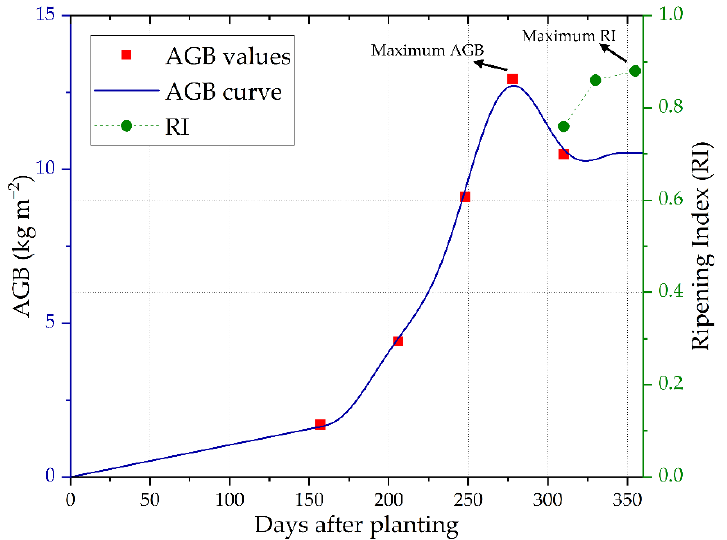
Figure 3. Measured above-ground biomass (AGB) and ripening index (RI) of the experimental